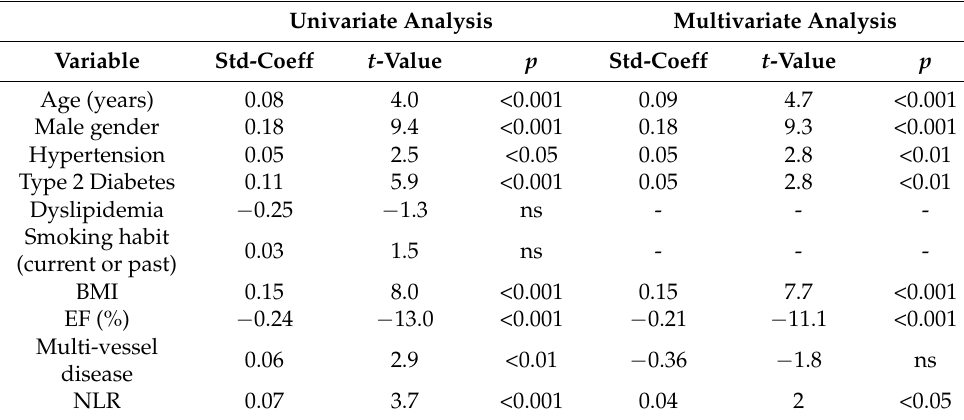
Table 2. Multiple regression between UA and different risk